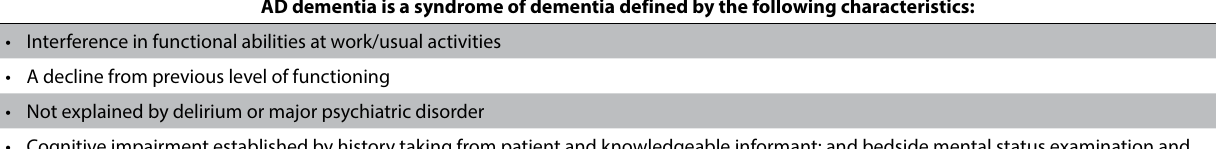
Table III. The NIA-AA clinical assessment characteristics in confirming diagnosis of AD 73 AD dementia is a syndrome of dementia defined by the following